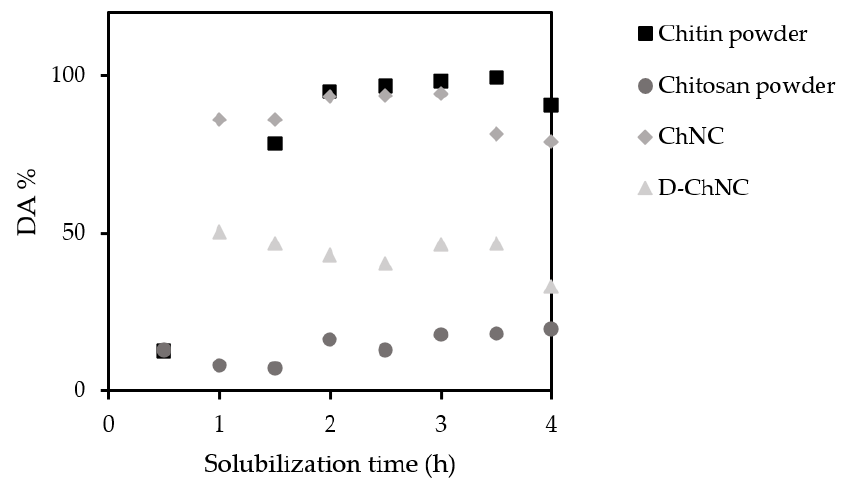
Figure A5. The measured DA of samples during solubilization (no incubation).